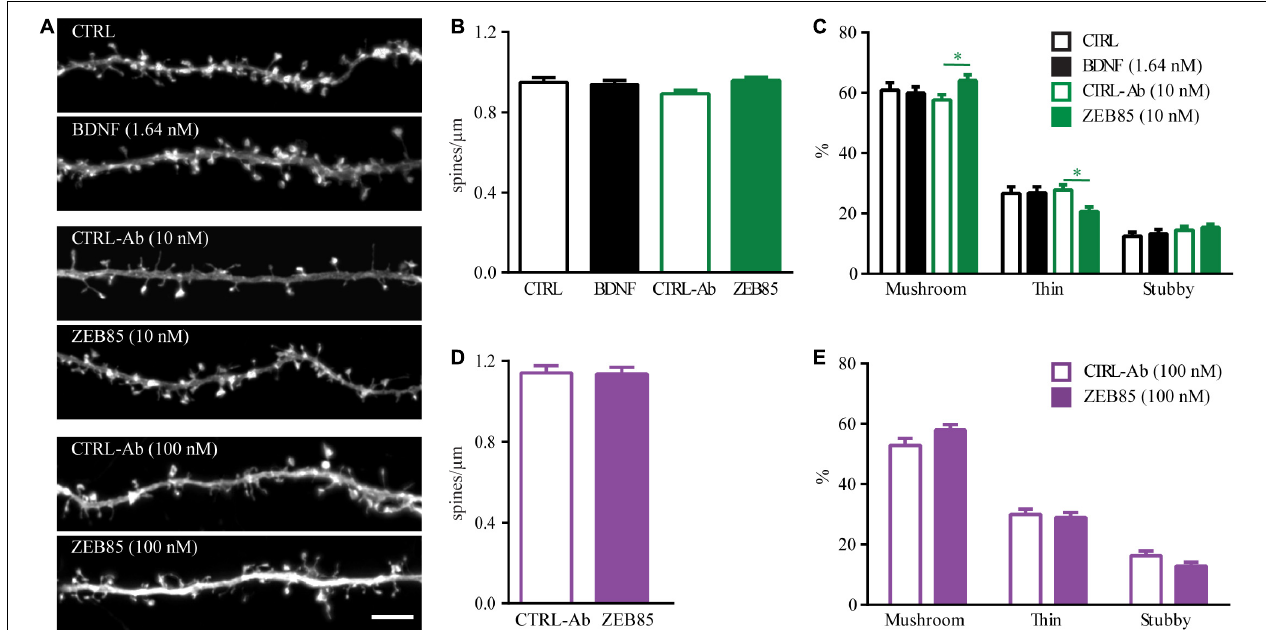
FIGURE 3 | ZEB85 affects spine type distribution in mature primary hippocampal neurons. (A) Representative dendritic segments with dendritic spines from feGFP transfected hippocampal neurons treated for 24 h with ZEB85 (10 nM and 100 nM), BDNF and the corresponding controls. Scale bar, 5 µ m. (B,D) Quantification of spine density (CTRL: n = 58 dendrites/neurons; BDNF: n = 59; CTRL-Ab 10 nM: n = 53; ZEB85 10 nM: n = 58; CTRL-Ab 100 nM: n = 45; ZEB85 100 nM: n = 44; N = 4 independent experiments). The data are presented as mean ± SEM and were tested using (B) a one-way ANOVA with Bonferroni post-test or (D) an unpaired t -test. (C,E) Quantification of spine type distribution (CTRL: n = 40; BDNF: n = 37; CTRL-Ab 10 nM: n = 52; ZEB85 10 nM: n = 52; CTRL-Ab 100 nM: n = 28; ZEB85 100 nM: n = 27; N = 3 independent experiments). The data are presented as mean ± SEM and were tested using a two-way ANOVA with